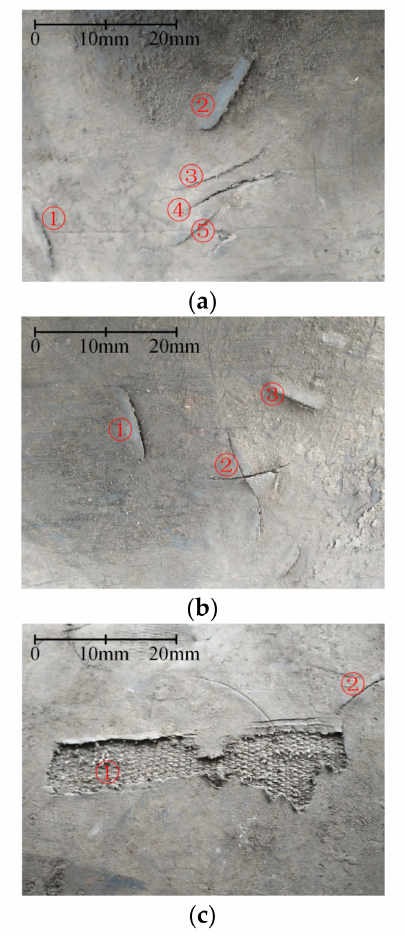
Figure 11. The scratches on the lower surface of the belt. There are five scratches in ( a ), three in ( b ), and two in ( c